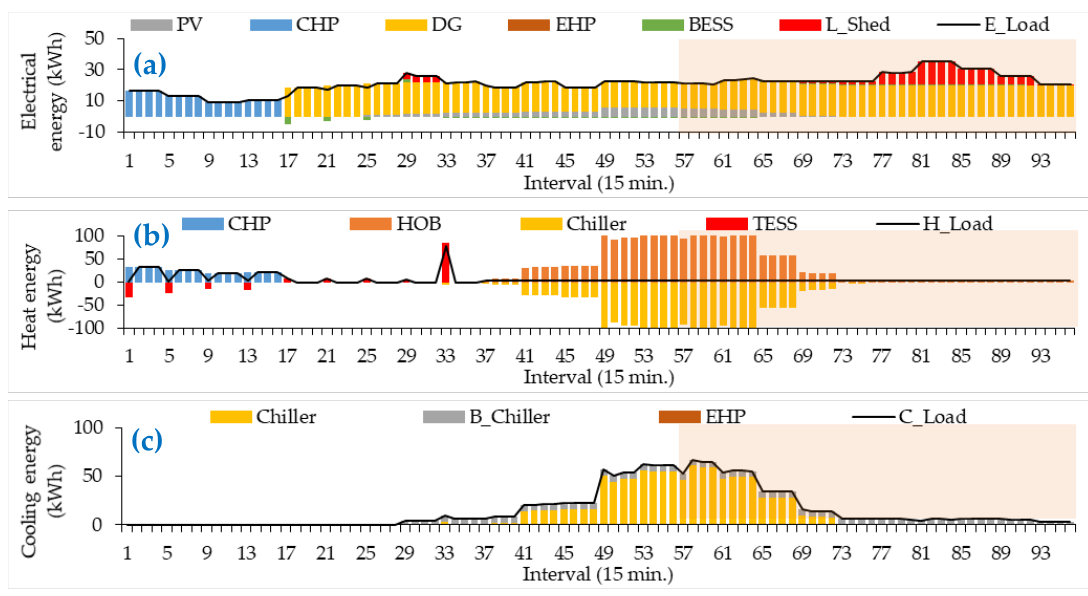
Figure 11. Energy balancing: ( a ) Electrical Energy; ( b ) Heat Energy; ( c ) Cooling Energy.